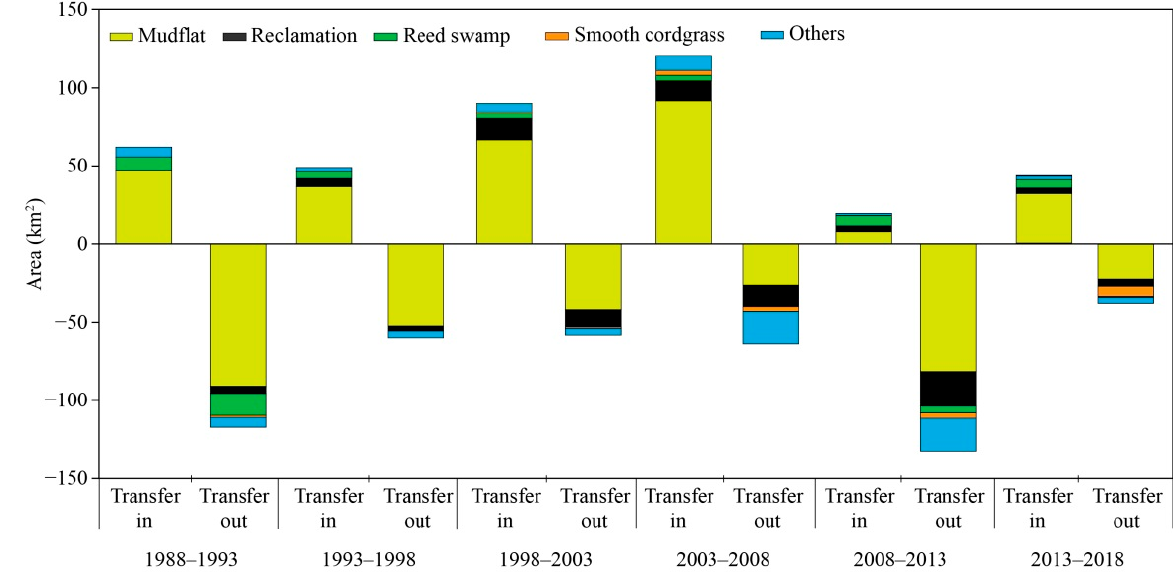
Figure 9. Land change between S. salsa saltmarsh area and other habitats near the Yellow River Delta wetland and the Guangli-Zhima estuarine wetland from 1988 to 2018.